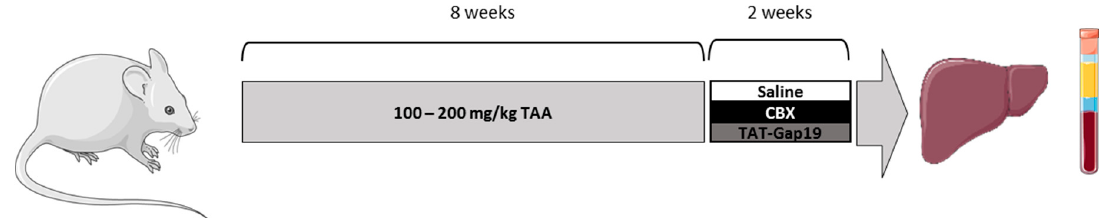
Figure 7. Experimental design. Mice were administered intraperitoneally with TAA for eight